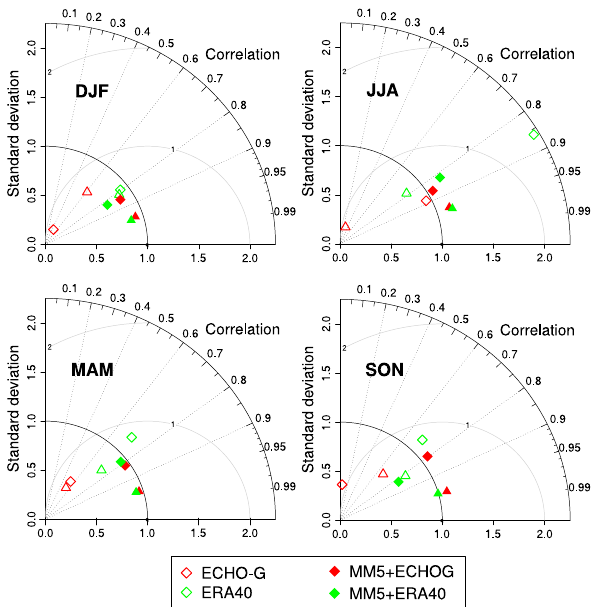
Fig. 5. Taylor diagrams of the spatial structure of the mean SAT and precipitation in the reference period. Triangles represent the corre- lation and variance ratio between the SAT seasonal mean values ob- tained by the models against the values of the E-OBS database. Di- amonds depict the same information regarding precipitation. Empty symbols represent the driving data, while filled ones represent the MM5 results. The colour distinguishes between ECHO-G (red) and ERA40 (green). All experiments have been interpolated to the E-OBS grid to perform the calculations.